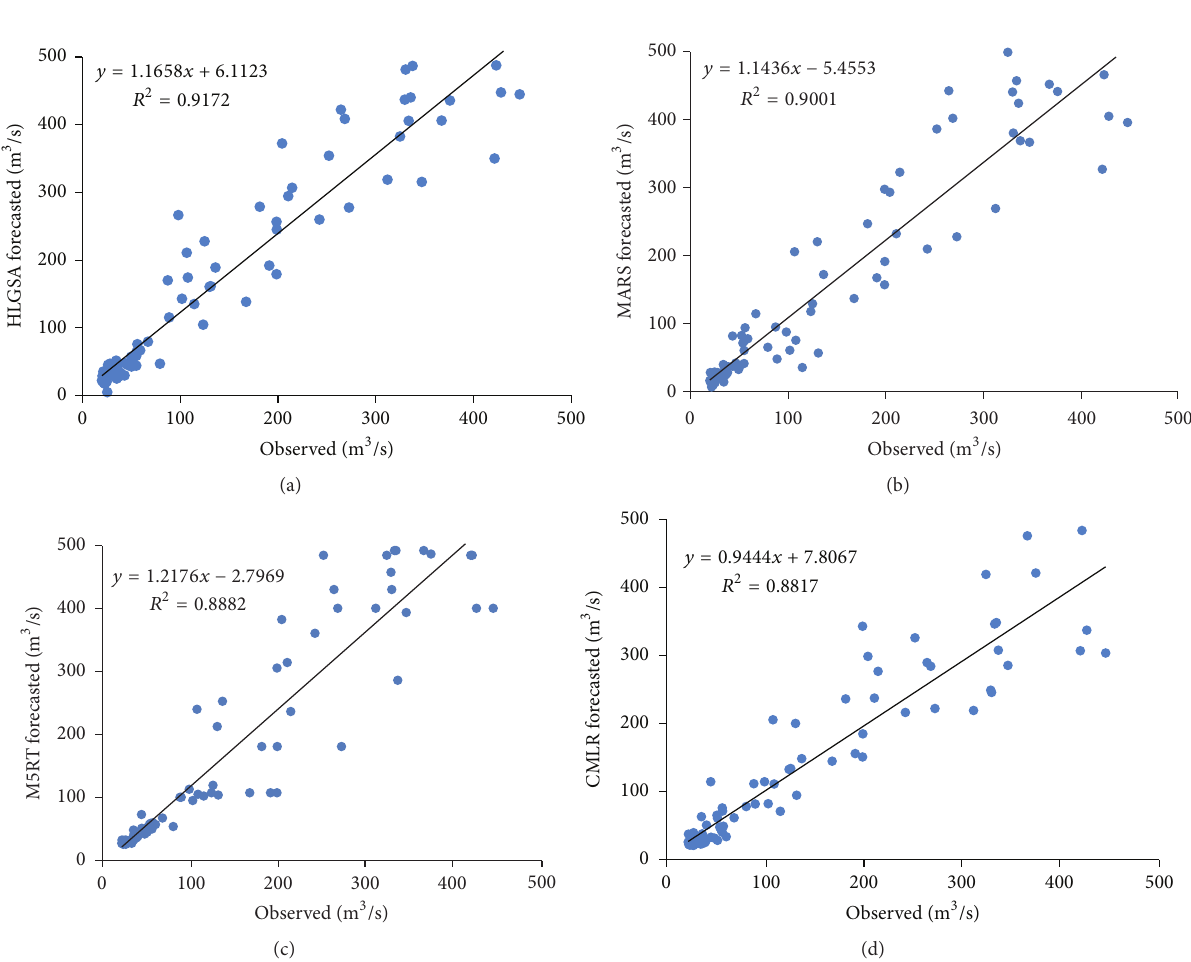
to MARS, M5RT, and CMLR methods (128.38, 141.13, and 151.21 m 3 /s), respectively. This is also true for RF MAE values where the best RF MAE for the proposed method is 55.75 m 3 /s compared to MARS, M5RT, and CMLR methods (69.52, 77.27, and 86.70 m 3 /s),